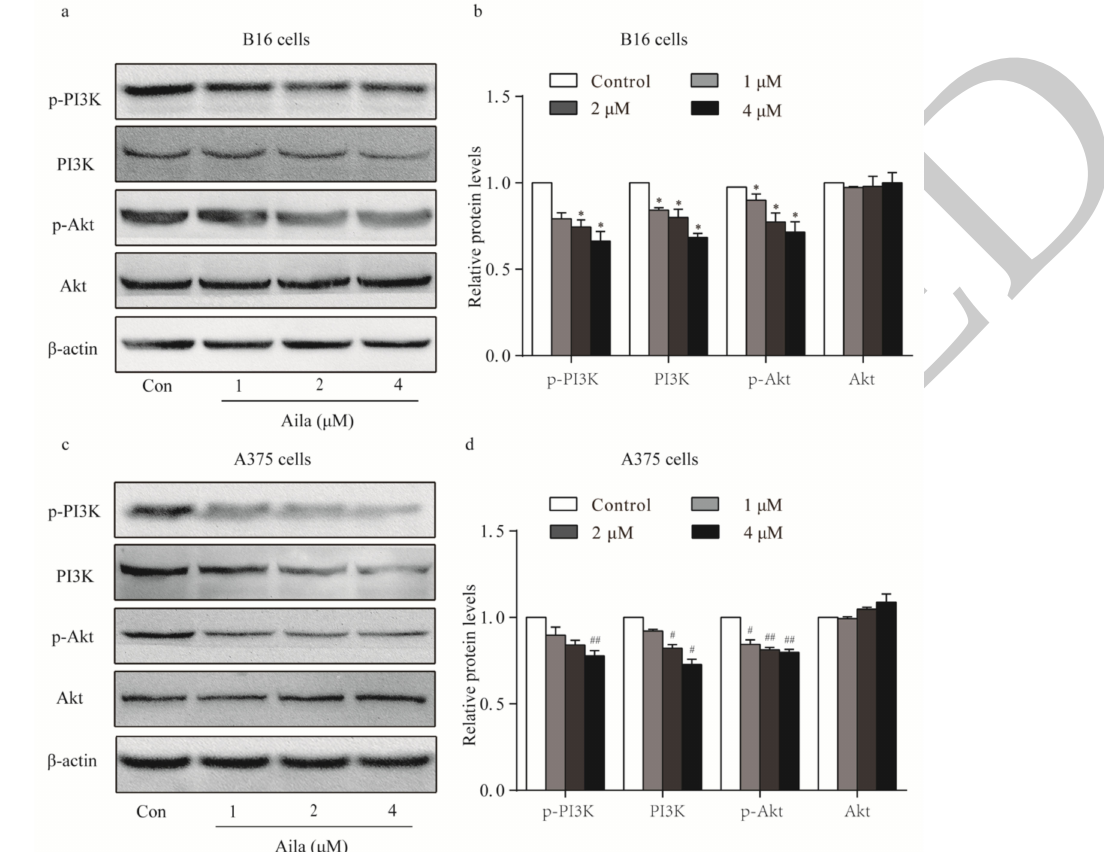
Figure 4. PI3K-Akt signaling is involved in the cell cycle arrest of ailanthone-treated melanoma B16 and A375 cells. ( a ) The levels of p-PI3K, PI3K, p-Akt, and Akt in ailanthone-treated B16 cells were examined by Western blotting. ( b ) Quantitative analysis of the levels of p-PI3K, PI3K, p-Akt, and Akt in ailanthone-treated B16 cells. * p < 0.05 compared with the control B16 cells. ( c ) The levels of p-PI3K, PI3K, p-Akt, and Akt in ailanthone-treated A375 cells were examined by Western blotting. ( d ) Quantitative analysis of the levels of p-PI3K, PI3K, p-Akt, and Akt in ailanthone-treated A375